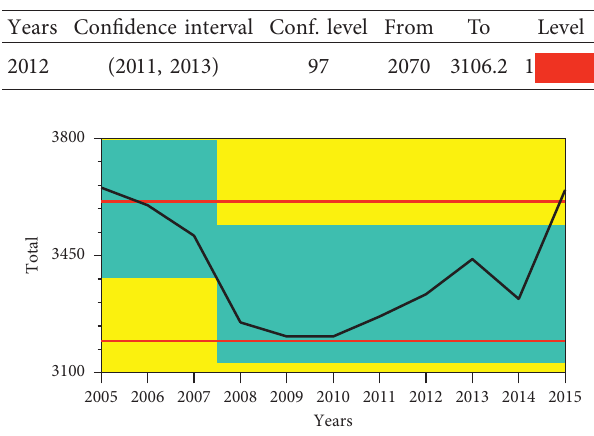
Figure 8: Eastern Cape: background